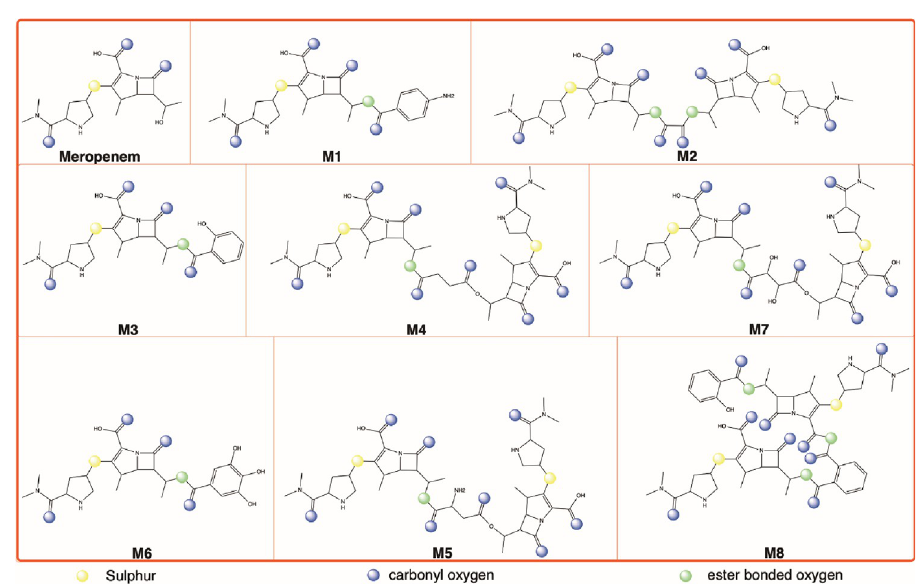
Fig 2. Chemical structures of Meropenem and its synthesized derivatives M 1 -M 8